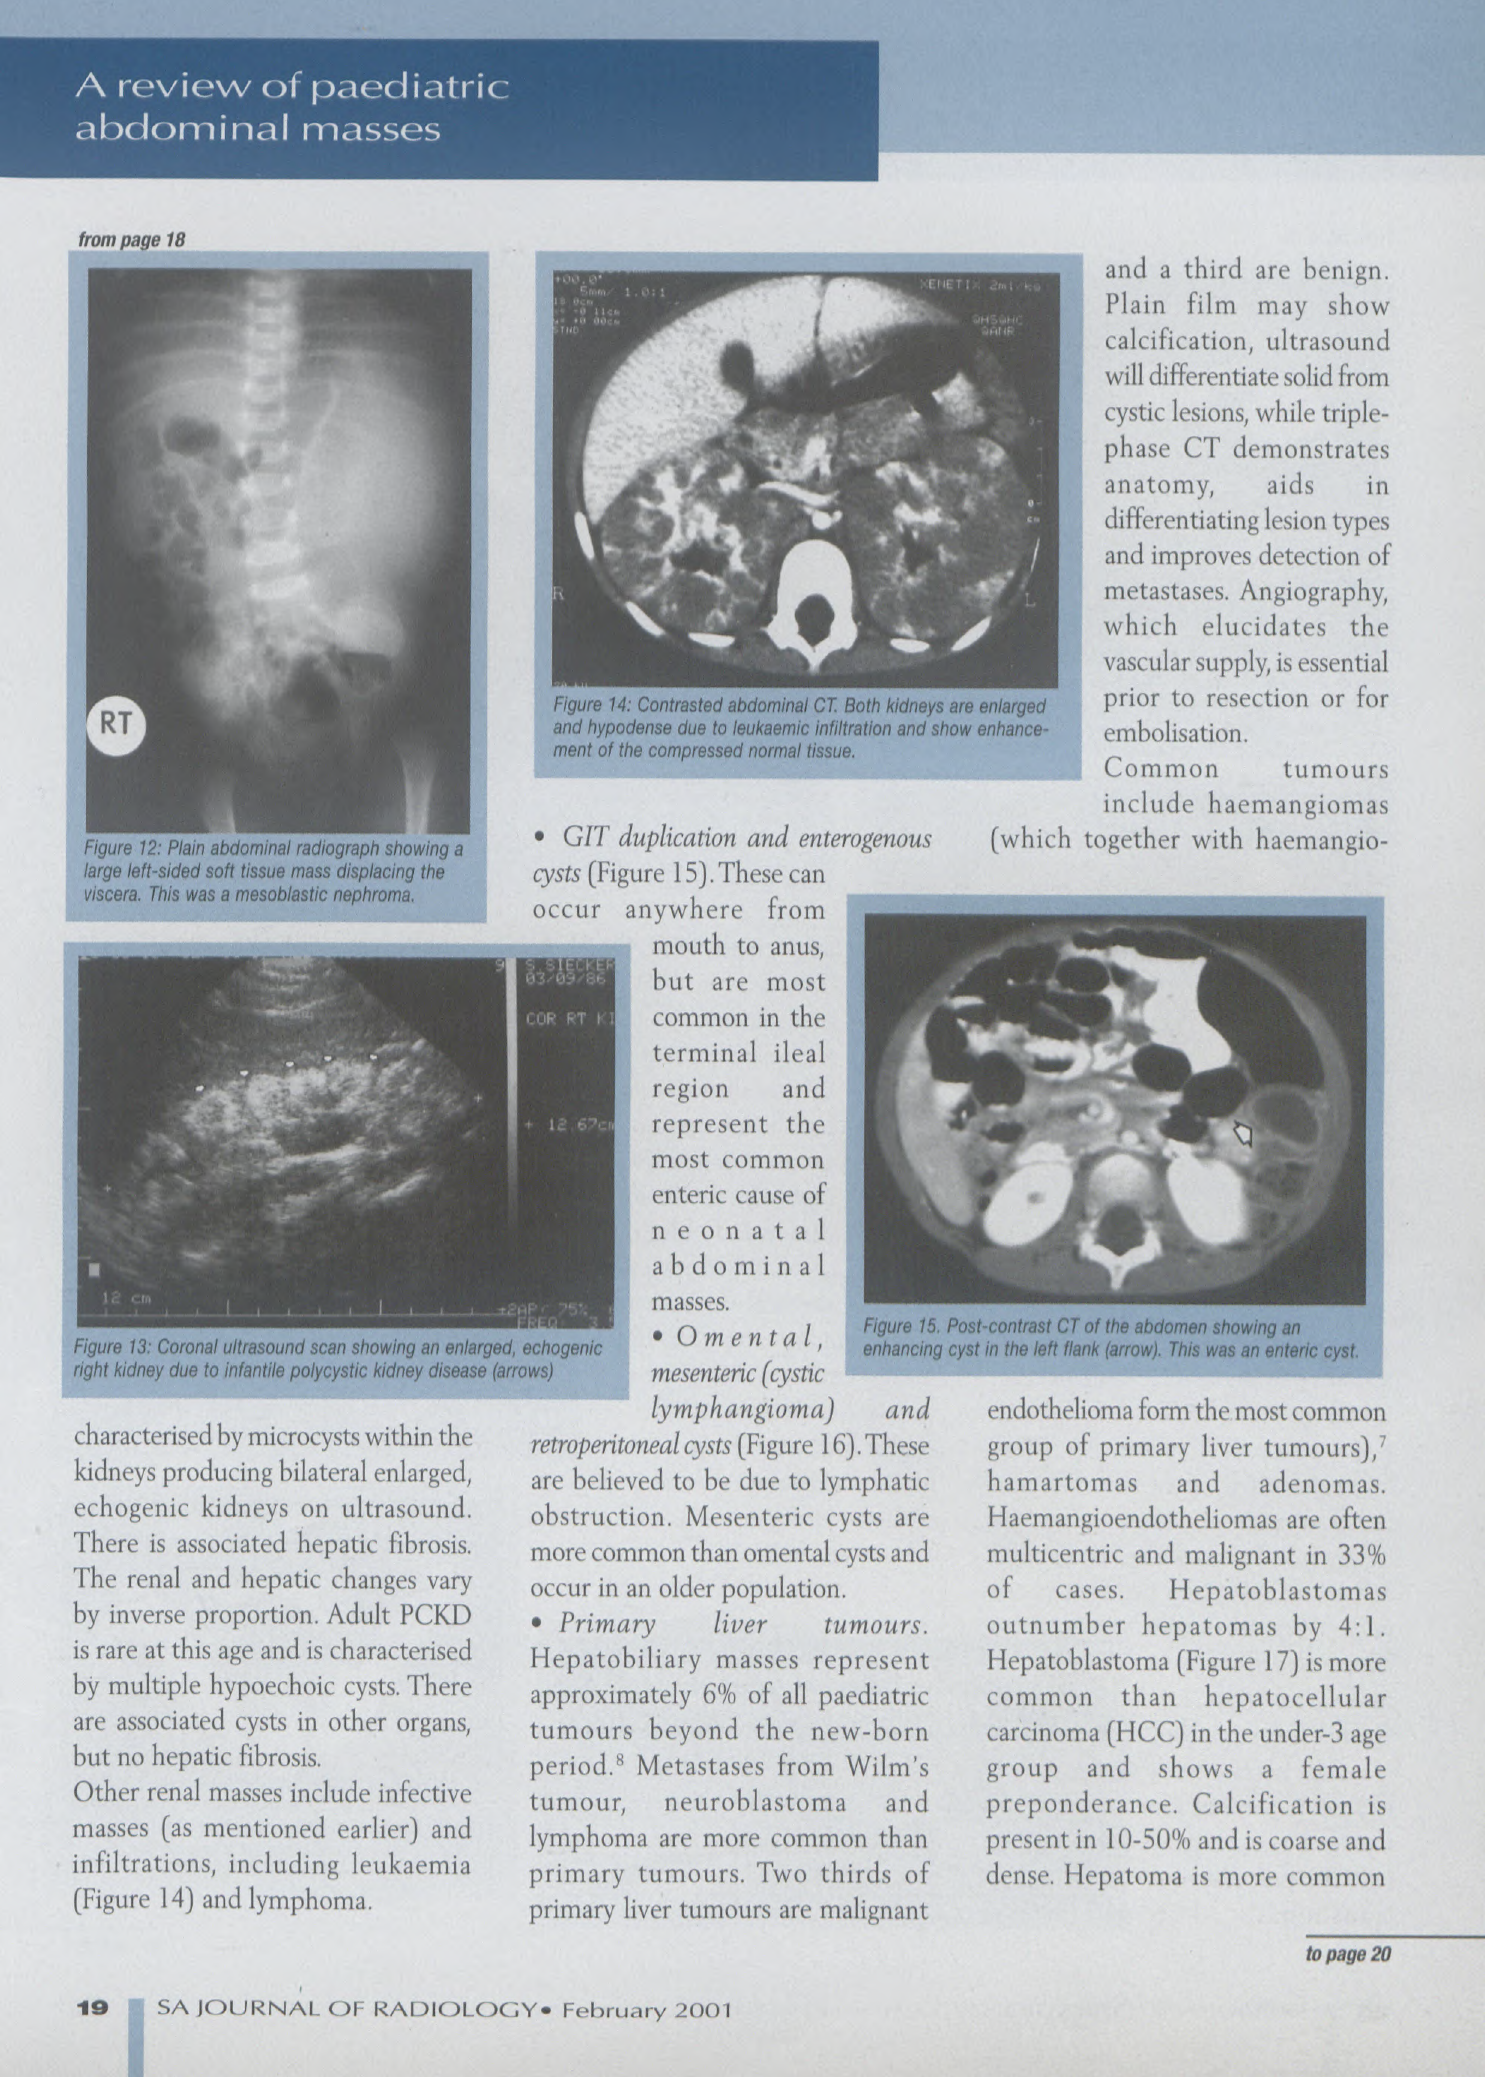
Figure 13: Coronal ultrasound scan showing an enlarged, echogenie right kidney due to infantile polycystic kidney disease (arrows)